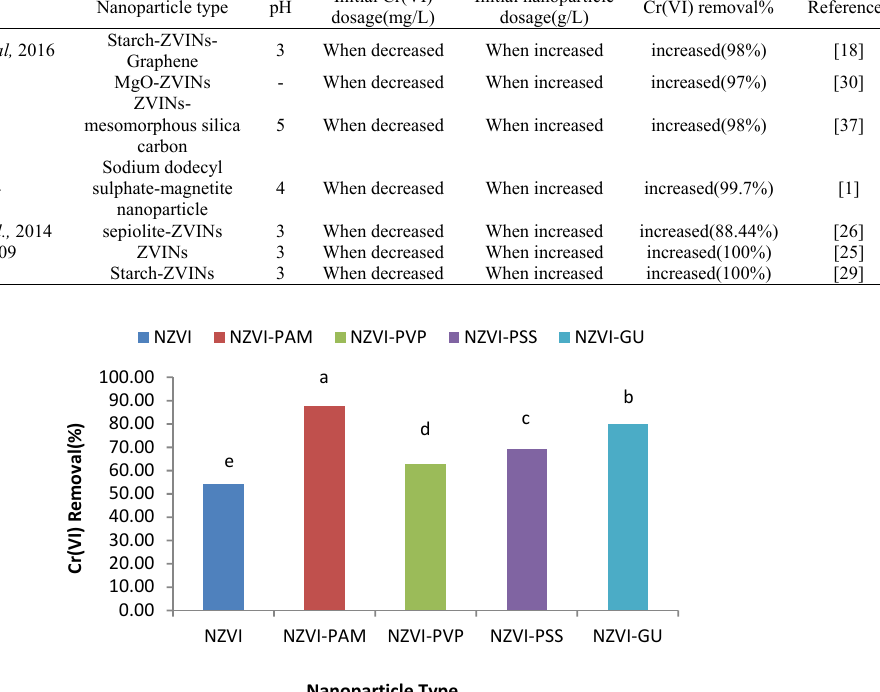
Fig.13.The comparison of bare and different polymer stabilized- ZVINs on the Cr(VI) removal Efficiency from